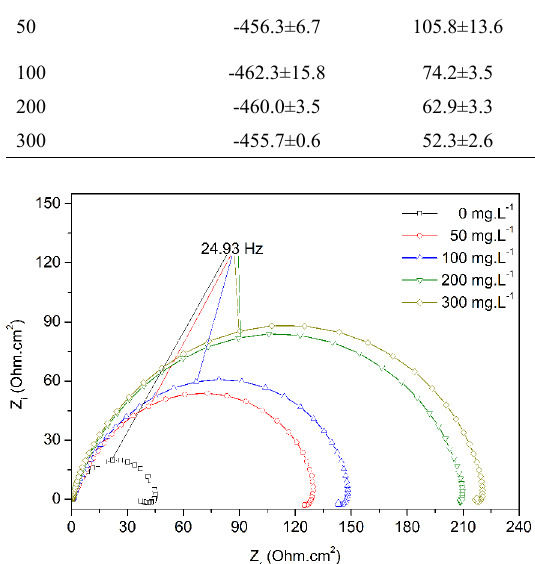
Table 1. Kinetic parameters obtained from Tafel plots for C-steel in 1.0 mol∙L -1 HCl without and with ethanolic Aniba canelilla extract at the following concentrations: 0, 50, 100, 200 and 300 mg∙L -1 at 25.0 °C. Concentration (mg·L -1 )